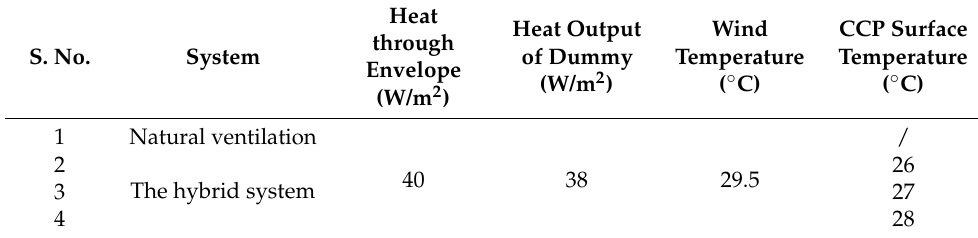
Table 2. Test designs for thermal comfort evaluation of the hybrid system.